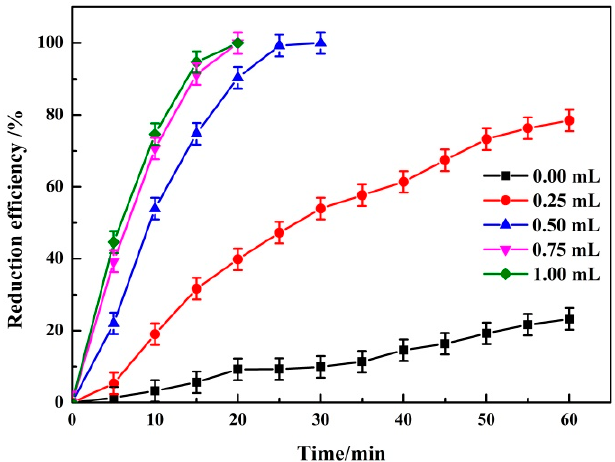
Figure 2 Effect of volume of H 2 SO 4 on reduction efficiency of chromium. Figure 2. Effect of volume of H 2 SO 4 on reduction efficiency of chromium. (Initial concentration of Cr (VI) = 1.000 g/L, current intensity = 0.05